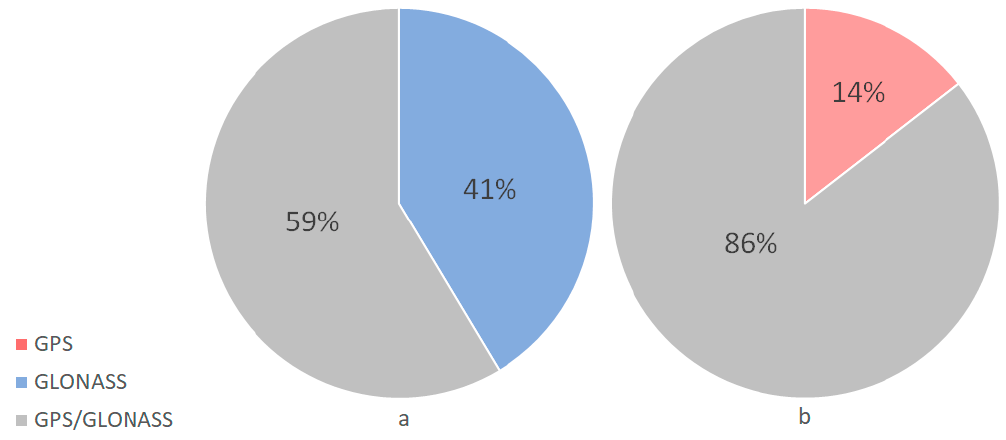
Figure 12. Constellation availability of wideband interference scenarios. ( a ) Scenario #5; ( b ) Scenario #6.